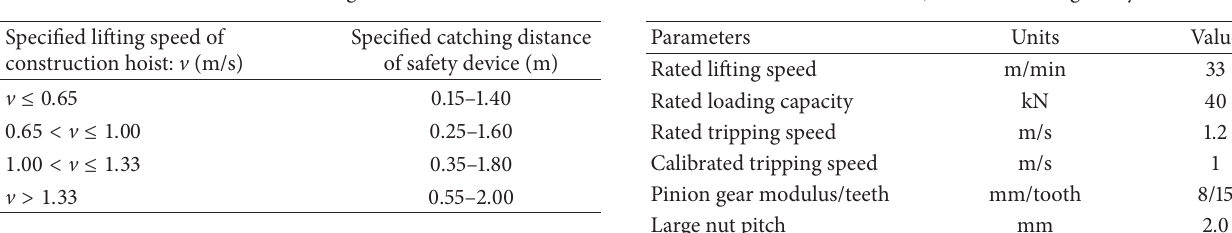
Table 2: The catching distance. Table 3: Parameters of SAJ40-1.2 antifalling safety